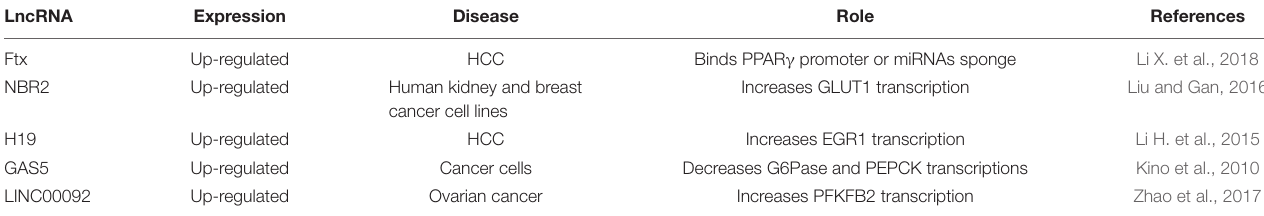
TABLE 3 | LncRNAs and carbohydrate metabolism regulation.